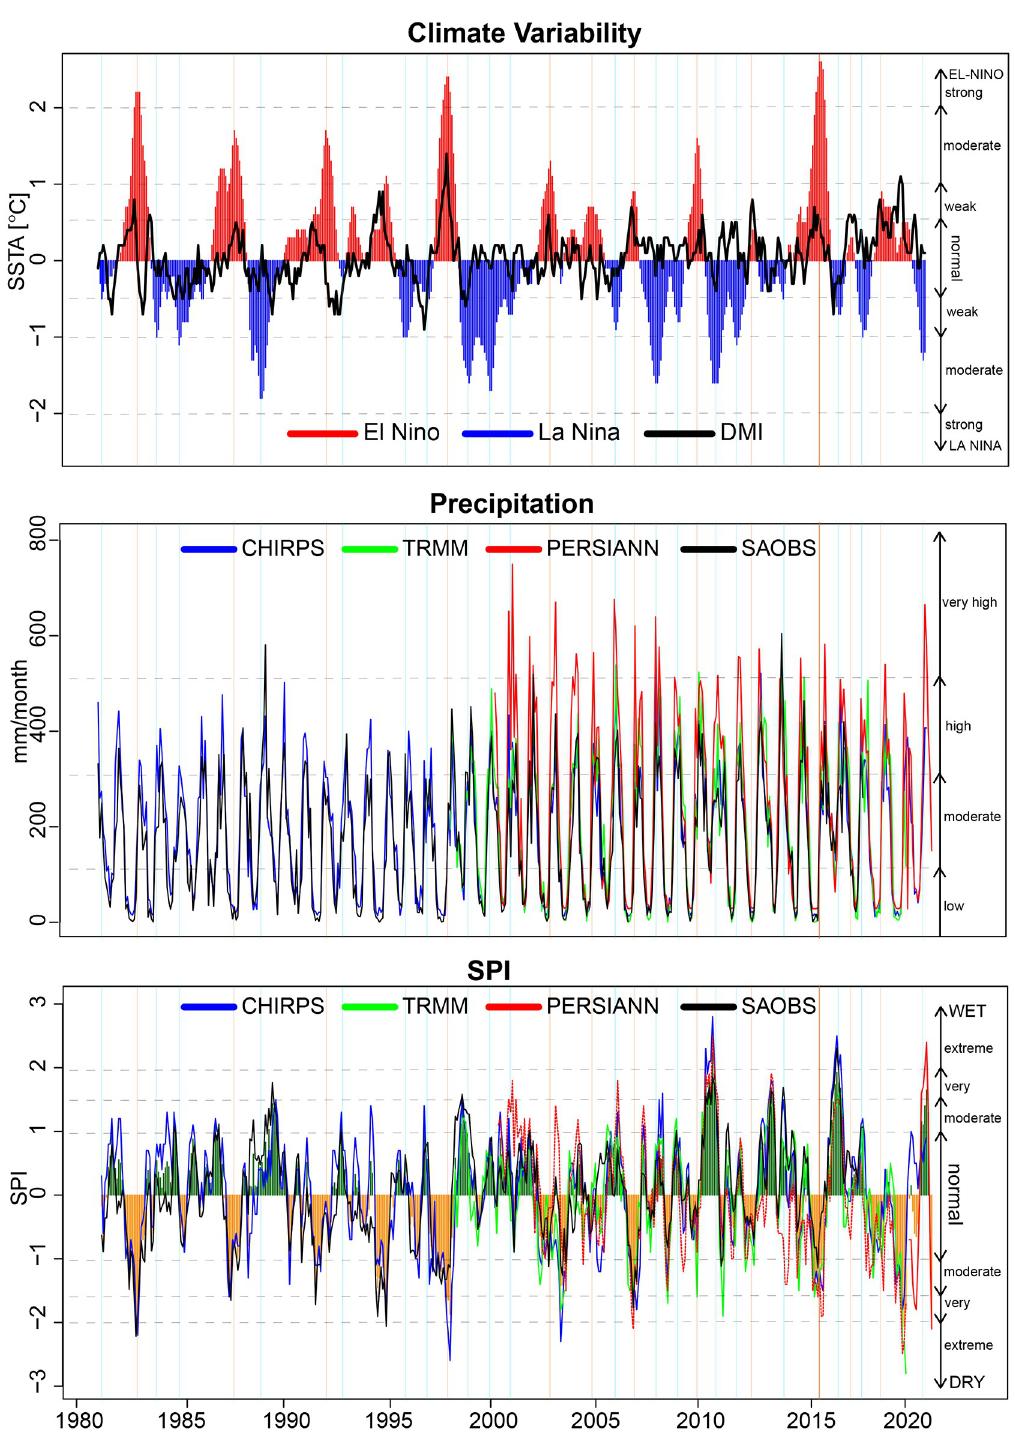
Fig 7. Time series of the Oceanic Nino Index (ONI) and Dipole Mode Index (DMI) for climate events during 1981–2020 (top), the monthly precipitation derived from all datasets (middle), and SPIs (bottom). For the SPI results, the colored bar shows the average from multiple sources, and the lines show the values derived from individual datasets: CHIRPS (blue), TRMM (green), PERSIANN (red), and SA-OBS (black). For each time series, the vertical orange solid line indicates a year with El Ni ñ o, and a vertical light-blue line indicates a year with La Ni ñ a. The horizontal gray dashed lines indicate the levels of ENSO (top), precipitation (middle), and SPI (bottom).